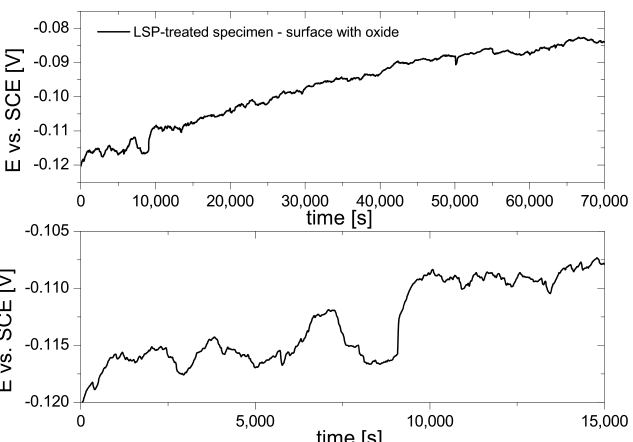
Figure 5. Evolution of corrosion potential E corr on oxidized surfaces after exposure testing in auto- clave of LSP-treated AISI-304L.